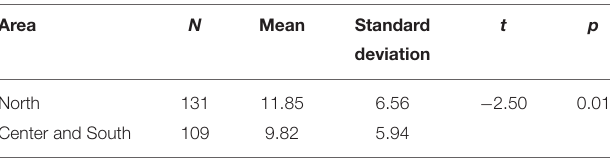
TABLE 7 | Areas of spent isolation and Edinburgh Postnatal Depression Scale (EPDS) scores.